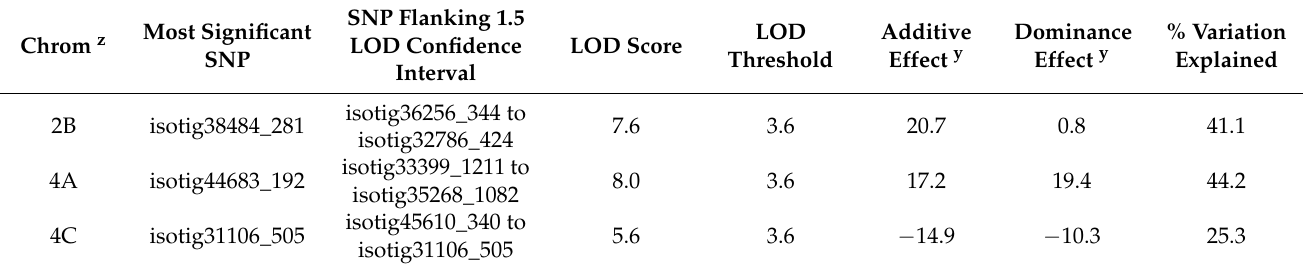
z Two linkage groups (4A and 4C) segregated independently and were assigned to chromosome 4 on the basis of common markers in the map of Damon and Havey [32]. y Positive effects indicate an increase in percentage survival conditioned by the chromosome region from W440.